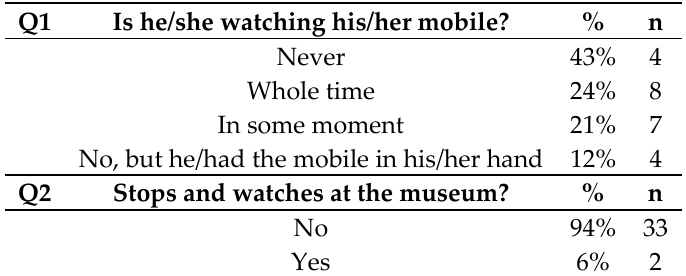
Table 1. Observations. Students’ behavior walking next to the museum. Q1 Is he/she watching his/her